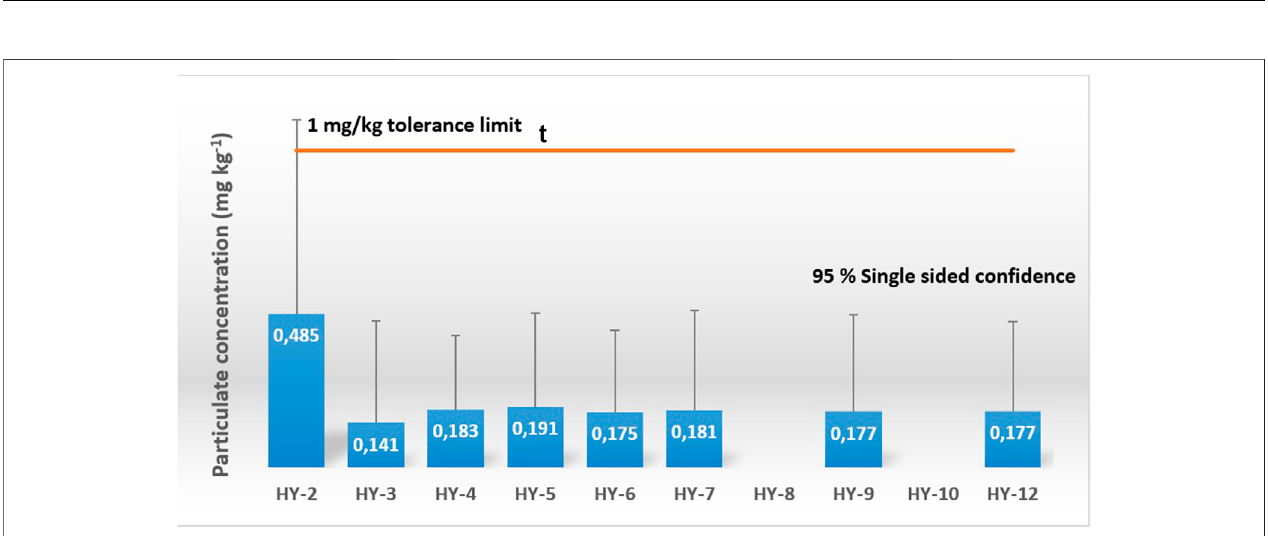
FIGURE4| Resultsfromsamplingofparticulates.Theresultsaregivenwitha95%singlesidedcon fi denceintervaloftheuncertaintybudgetofthemeasurements. No samples were collected for HY-8 and HY-10 due to sampling adapter failure.